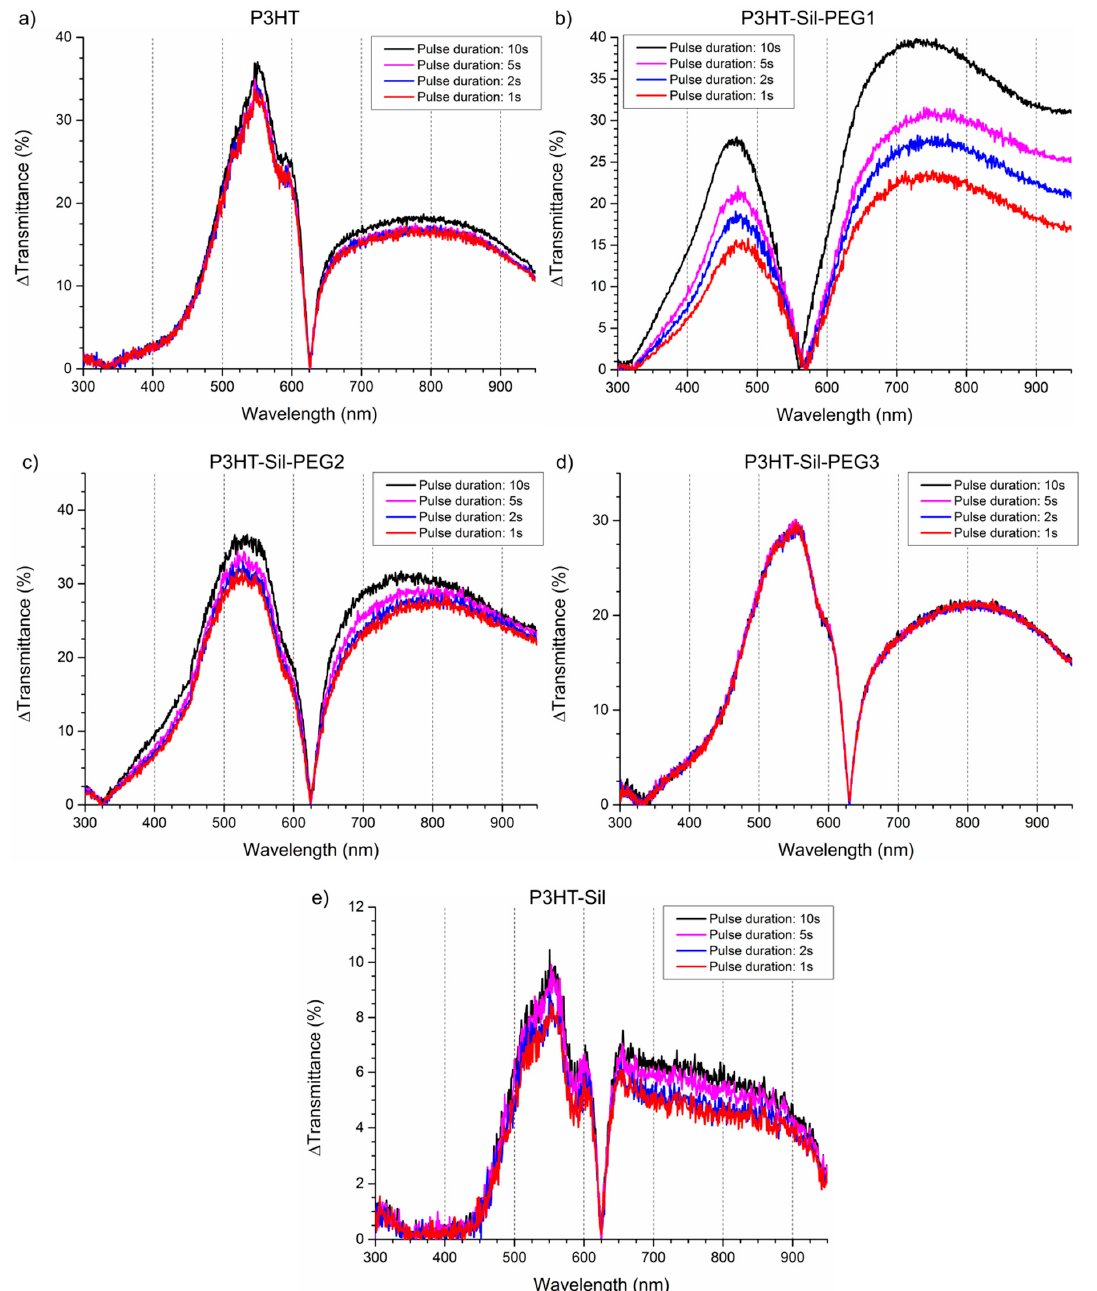
Figure A8. Colour contrasts (given as the absolute value of transmittance differences between the undoped and doped states) plotted versus wavelength for films of the investigated copolymers: ( a ) P3HT; ( b ) P3HT-Sil-PEG1; ( c ) P3HT-Sil-PEG2; ( d ) P3HT-Sil-PEG3; ( e ) P3HT-Sil.